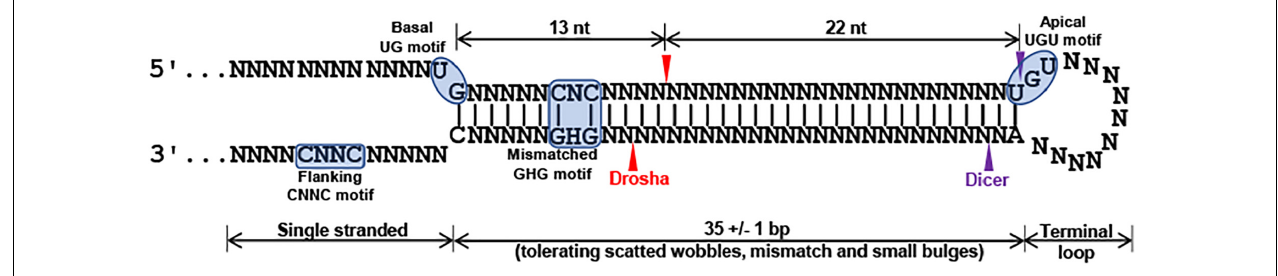
FIGURE 6 | Structural and primary sequence features of pri-miRNA stem of canonical miRNA hairpin (modified from Fang and Bartel, 2015; Nguyen et al., 2015; Bartel, 2018). A canonical miRNA hairpin includes a 35 + / − 1 bp stem, an unstructured terminal loop and singled stranded flanking regions. A basal UG motif, a mismatched GHG motif (H = A, C or U), an apical UGU motif, and flanking CNNC (N = any of the four nucleotides) motif enhance the processing and the precision of Drosha cleavage (red arrowheads). Purple arrowheads mark the sites for DICER